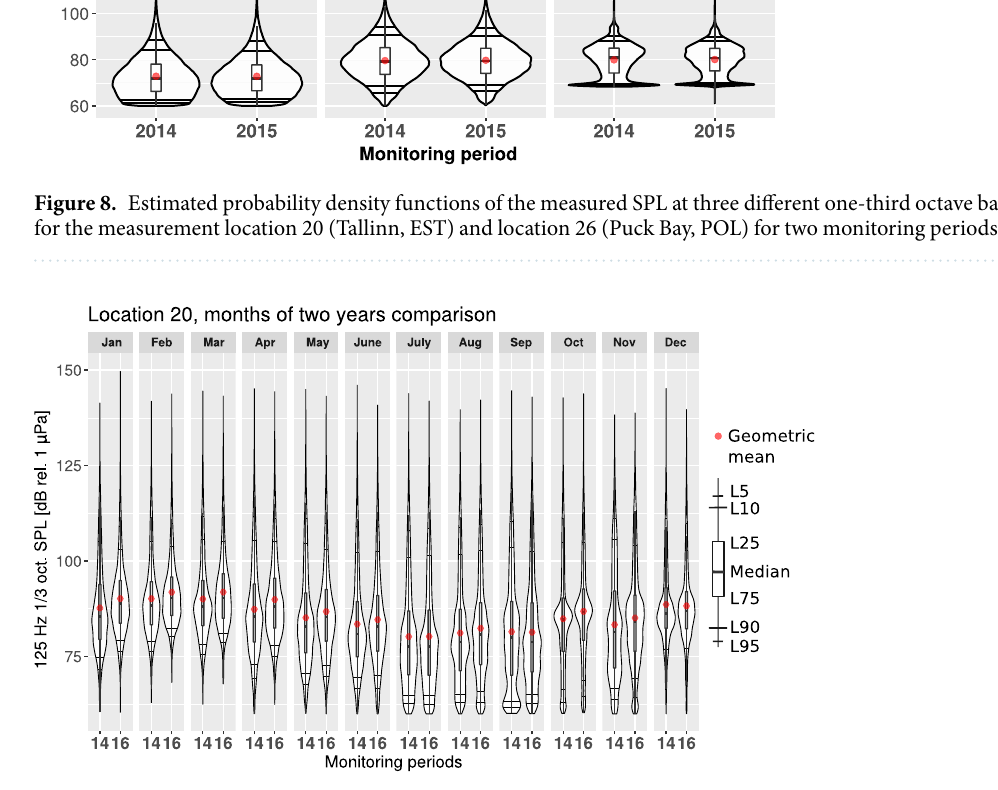
Figure 9. Comparison between monthly estimated PDFs from two separate monitoring periods in the 125 Hz one-third octave band for the measurement location 20 (Tallinn). The number 14 on the x-axis marks the monitoring period from from 1 January 2014 to 31 December 2014 and the number 16 marks monitoring period from from 1 November 2015 to 31 October